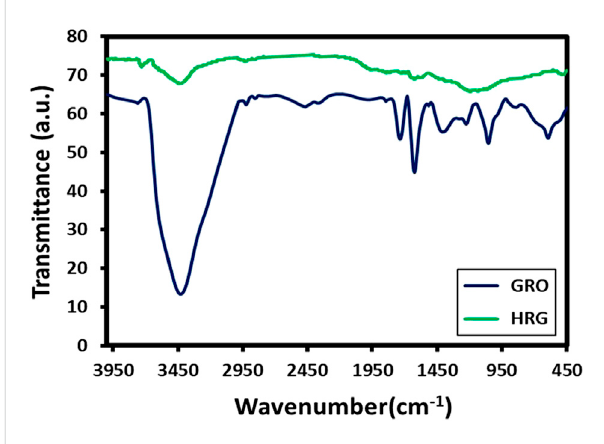
FIGURE 2 FT-IR spectra of Graphite oxide (GRO) and highly reduced graphene oxide